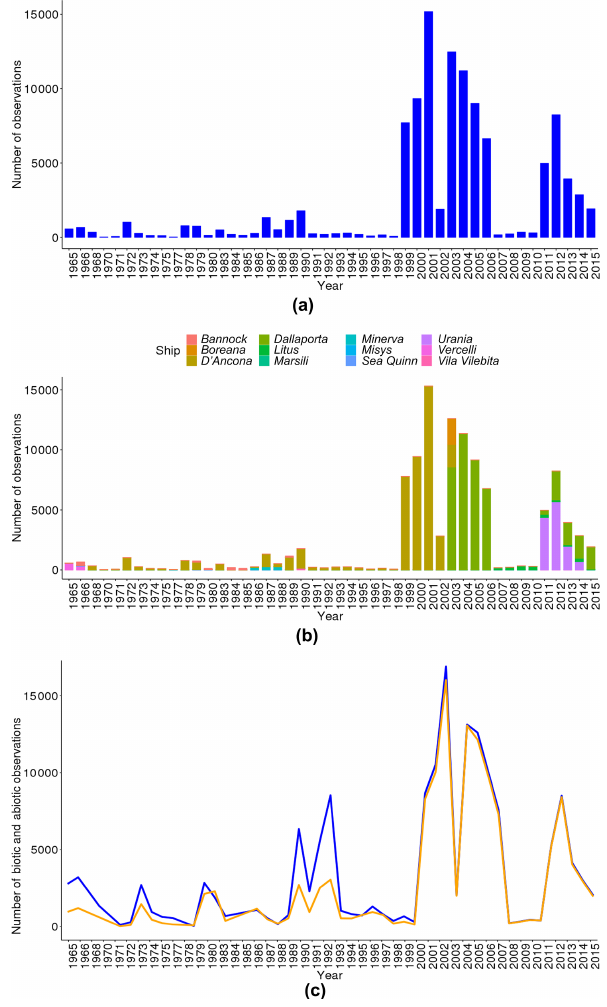
Figure 5. Distribution over the years of the temperature (a) , chloro- phyll a (b) , and phytoplankton (c)